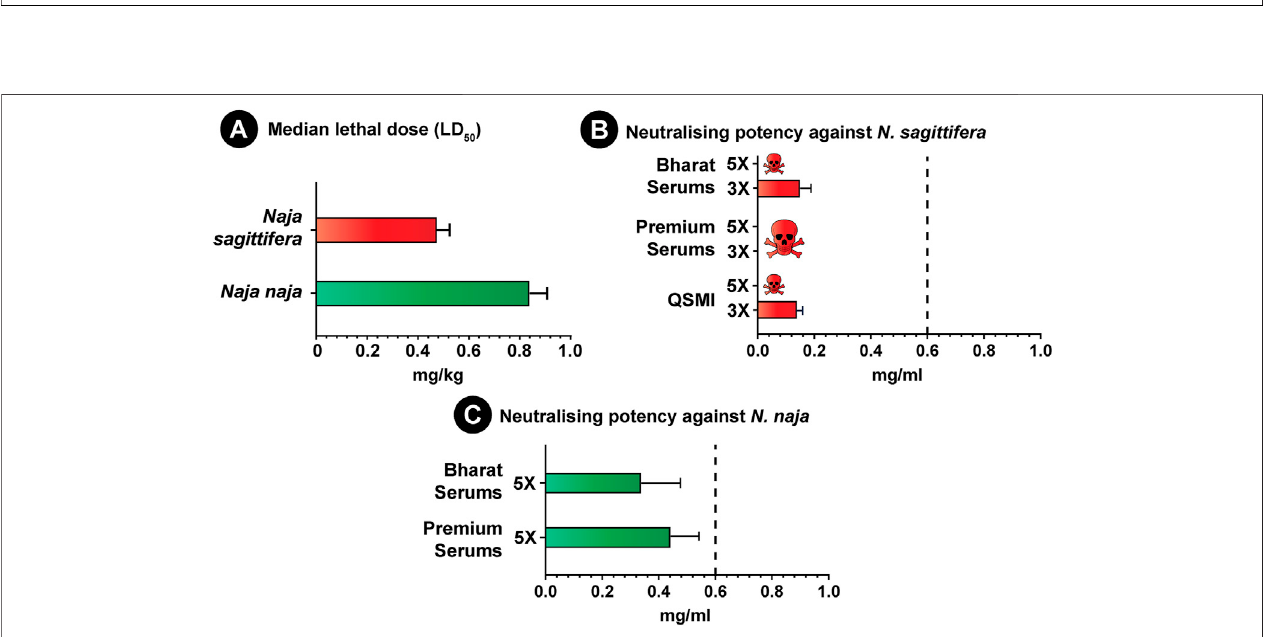
FIGURE 6 | Venom toxicities of N. naja and N. sagittifera and the neutralisation potential of commercial antivenoms. (A) in this fi gure depicts the venom potencies (mg/kg)of N.naja and N.sagittifera ,whiletheneutralisingpotencies(mg/ml)ofIndianpolyvalent(PremiumSerumsandBharatSerums)andThaimonovalentantivenoms againstthe Naja venoms (3X and5X LD50 challenge dose) areshown in (B,C) .Thedottedverticallinein (B,C) representsthemarketed claimofneutralisation(0.60 mg/ ml) against N. naja and N. kaouthia for the Indian polyvalent and Thai monovalent antivenoms, whereas the error bars represent 95% con fi dence intervals.